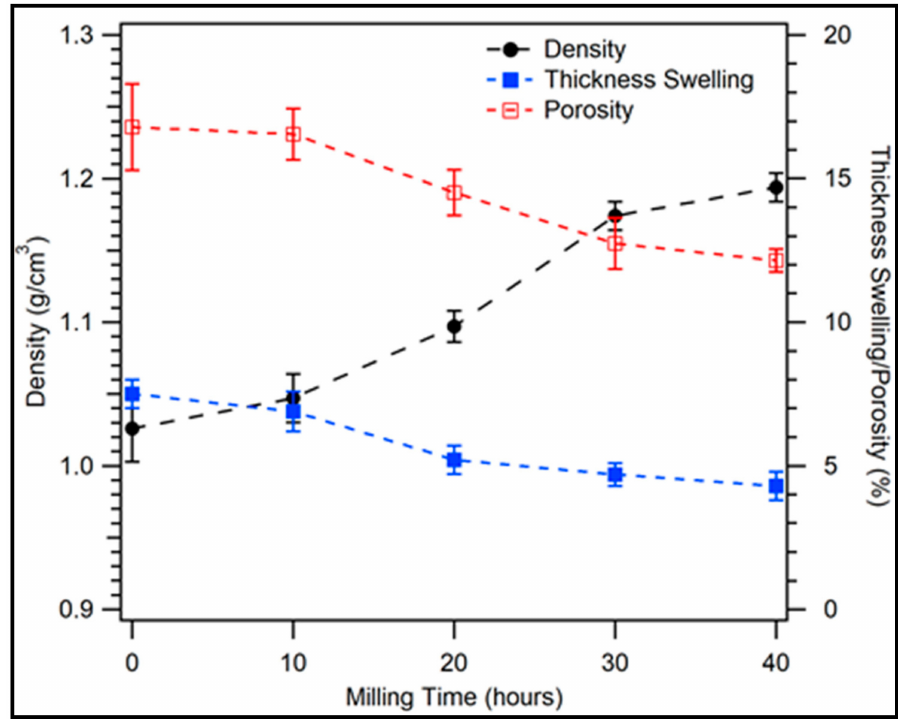
Figure 8. Density, thickness swelling, and porosity of the biocomposite for various milling